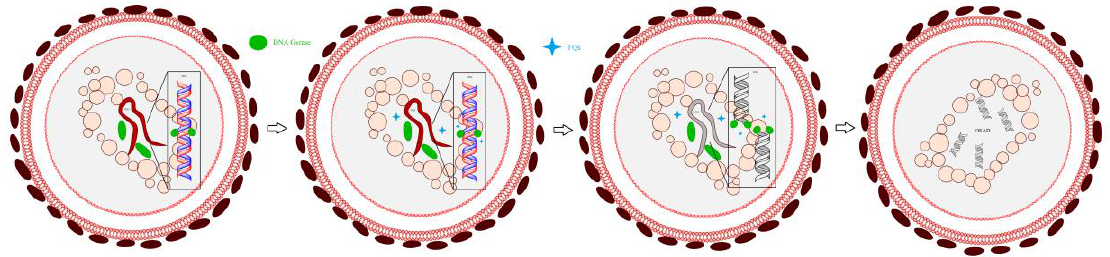
Figure 2. Mechanism of fluoroquinolone action in bacterial cells.